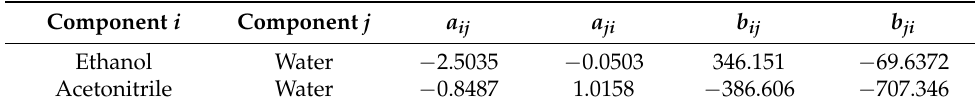
and acetonitrile/water mixture.